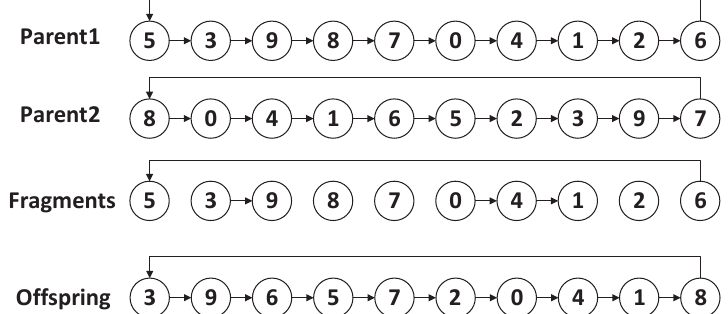
Figure 7. An example of crossover and greedy reconnection.